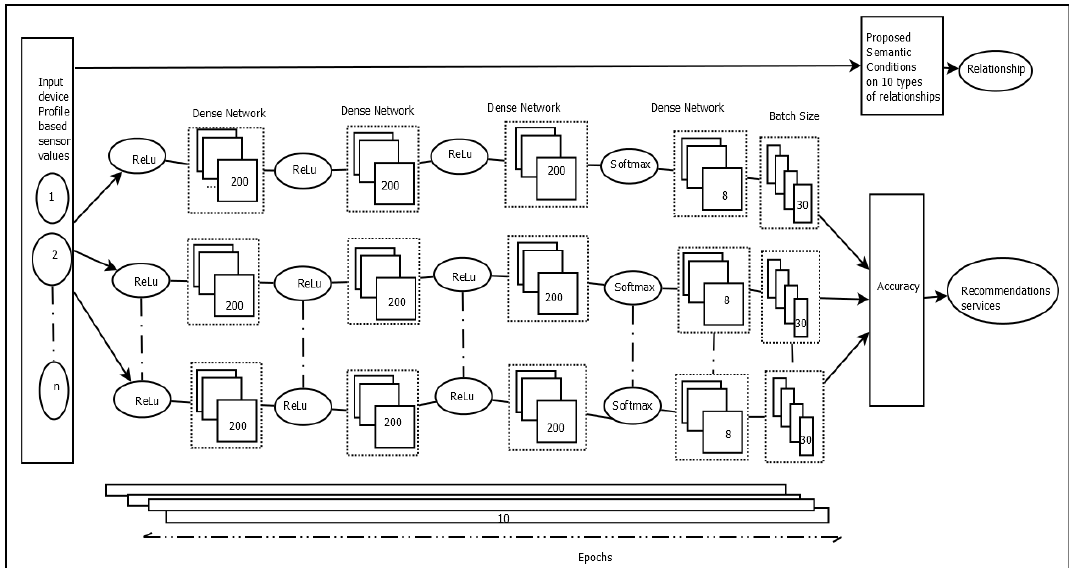
Figure 5. Proposed relationship artificial neural network (R-ANN) knowledge